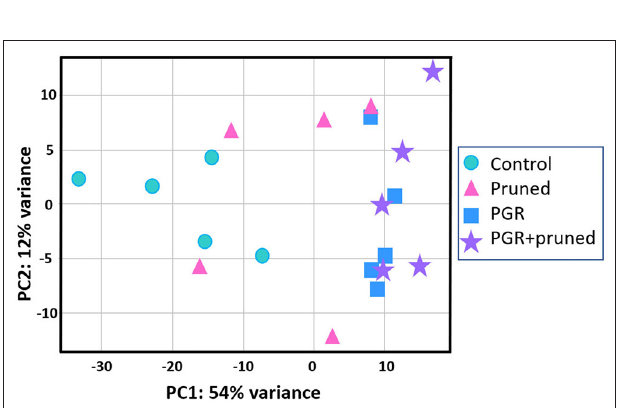
FIGURE 5 | Comparison of DEGs by PCA with respect to control, pruned, PGR and PGR + pruned treatments. Data represent five biological replicates. DEG, differentially expressed genes; PCA, principle components analysis; PGR, plant growth